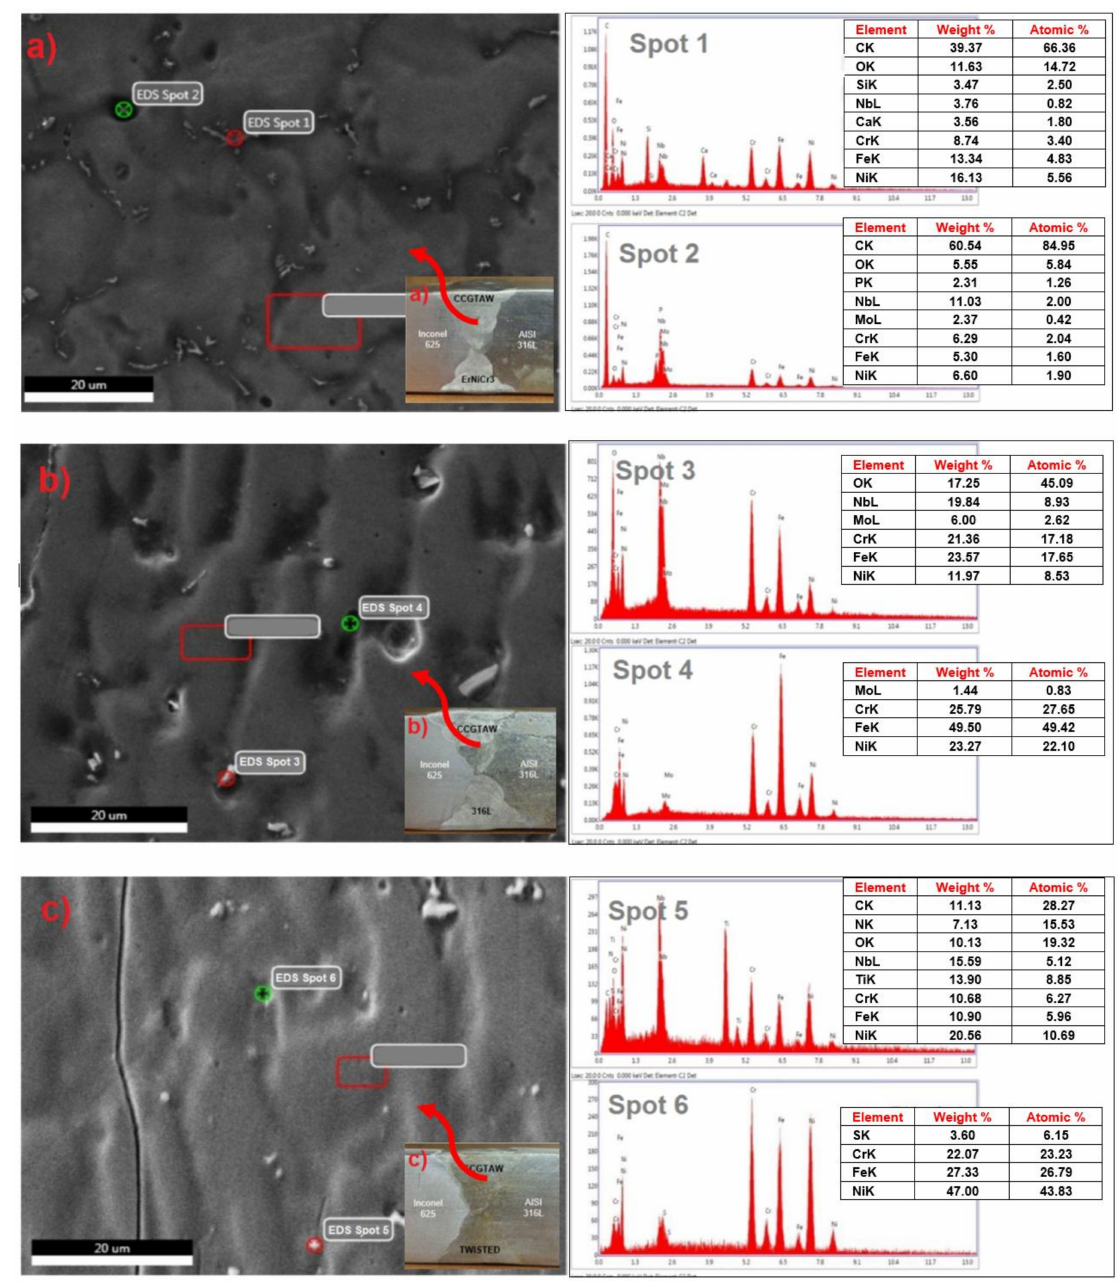
Figure 8. SEM/EDAX point analysis of the dissimilar CCGTA welding of Inconel 625 and AISI 316L, employing ERNiCr-3 ( a ), TIG 316L ( b ), Twisted Filler ( c ).